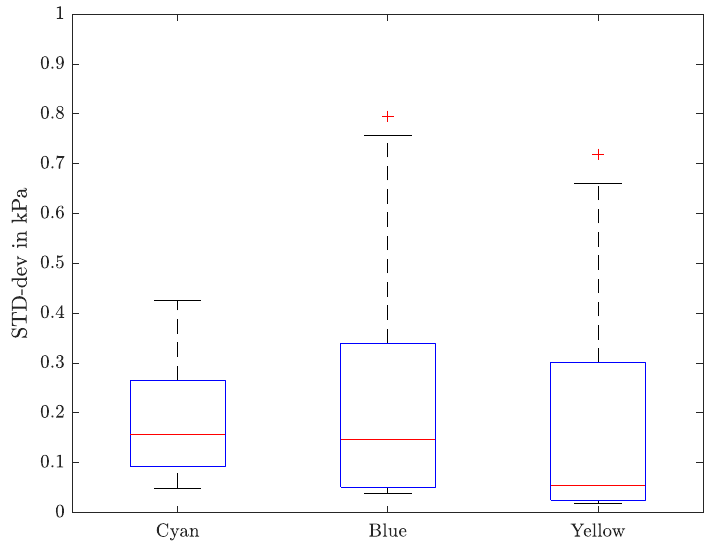
Figure 10. The standard deviation (STD-dev) for each sample with a contact force of about 0.1N is shown in a box plot, in which the median value is indicated as red